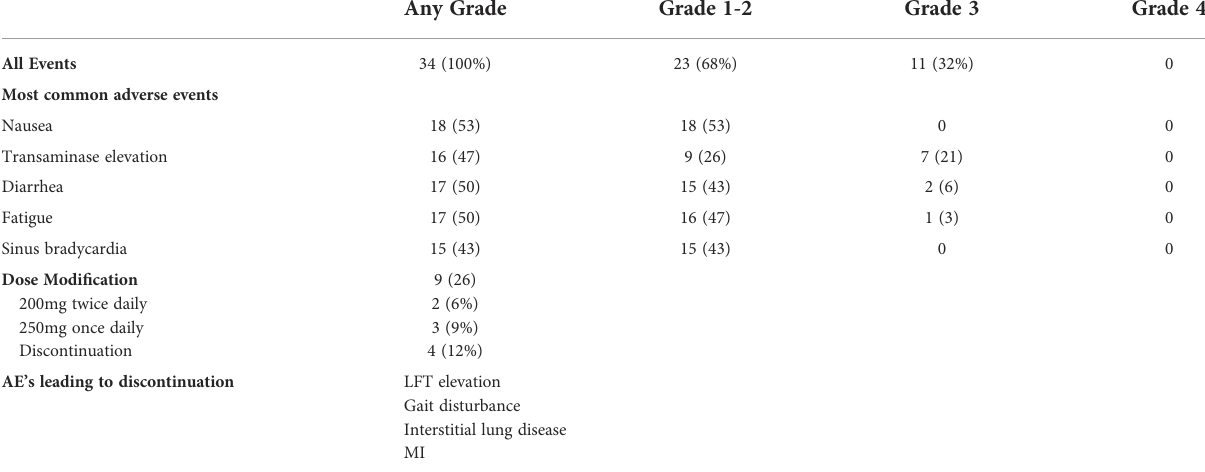
TABLE 5 Most Common Treatment-Related Adverse